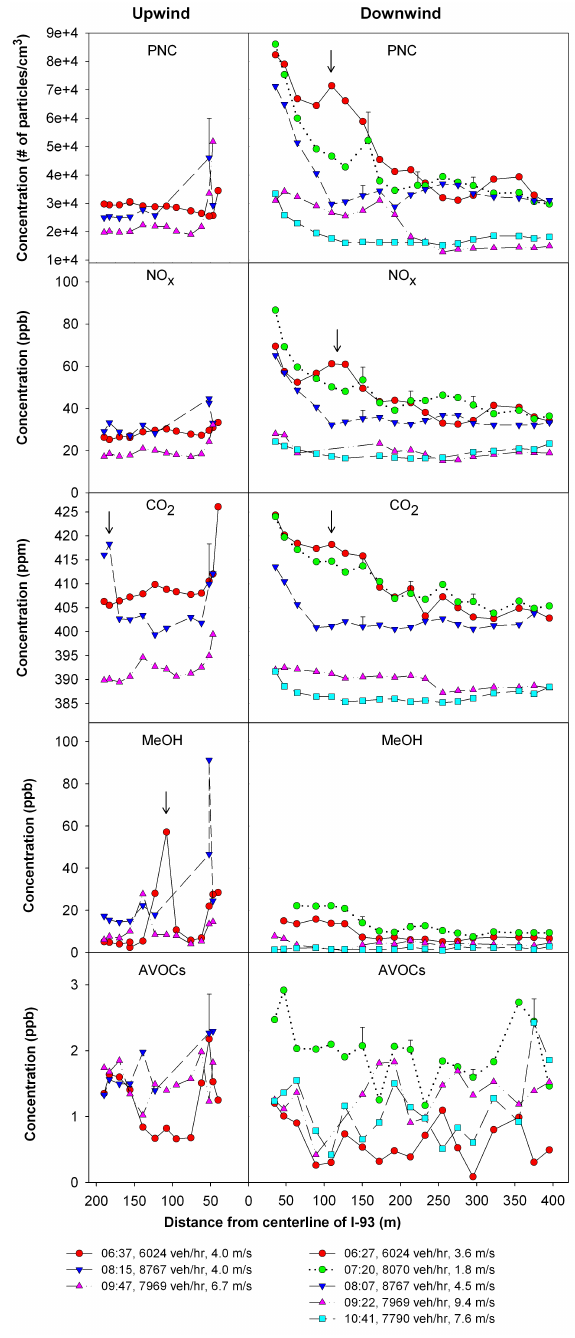
Fig. 3. Spatial and temporal variation of particle number concen- tration (7–1000nm), NO x , CO 2 , methanol (MeOH), and aromatic VOCs (AVOC) along transects perpendicular to I-93. Legend shows vehicles per hour on I-93 (both directions) and average hourly wind speed. Pollutant spikes indicated with arrows likely represent the plumes from vehicles passing nearby the AML; spikes immediately upwind of the highway were likely due to traffic on Rt. 38. Er- ror bars (one SD) are shown at locations where the AML stopped briefly and multiple measurements were